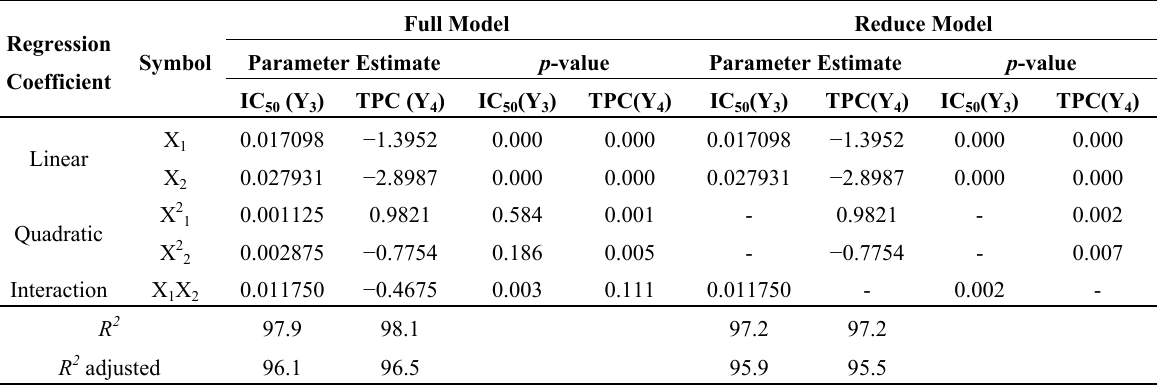
Table 3. Regression coefficient parameters of samples extracted with 80%